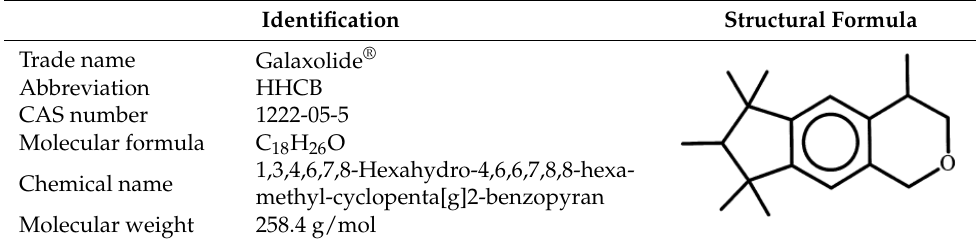
Table 1. HHCB nomenclature and identification features and structural formula.